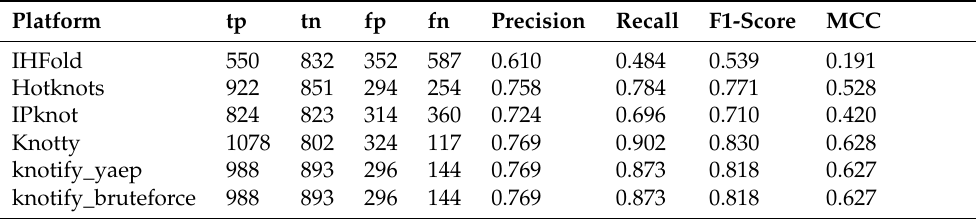
Table 7. Precision, recall, F1-score, and MCC per platform for sequences of length >= 30 and < 40.